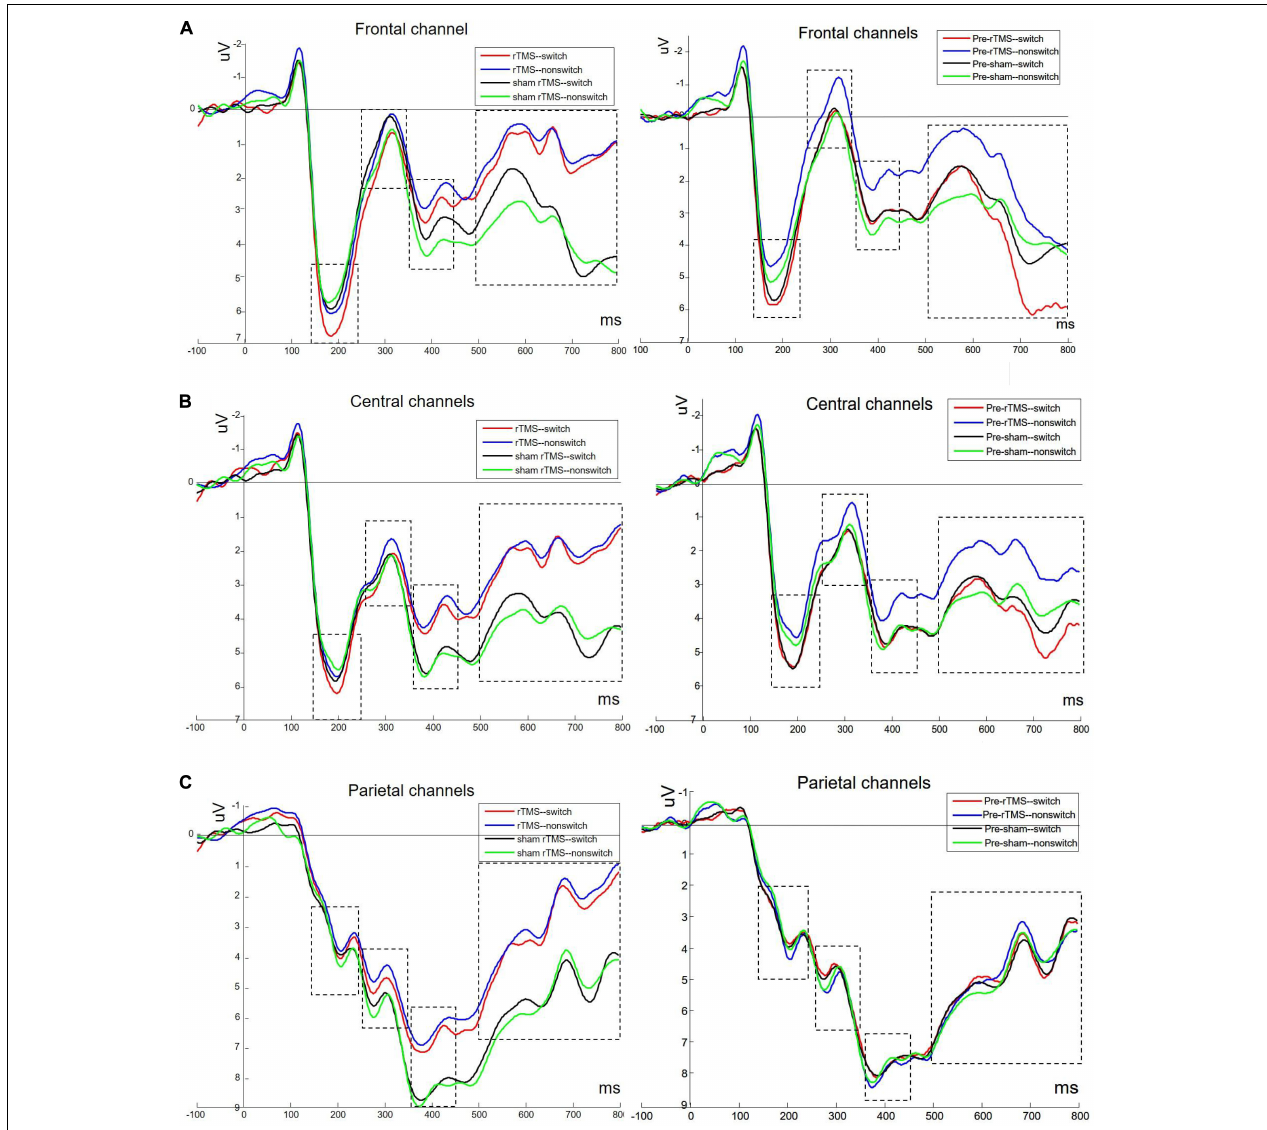
FIGURE 2 | Grand averaged ERPs to switch and non-switch conditions at frontal ( A : average of channels 4, 27, and 31), central ( B : average of channels 8, 23, and 32), and parietal channels ( C : average of channels 12, 13, and 19) for 1 Hz rTMS and sham rTMS stimulations, including post-stimulation and